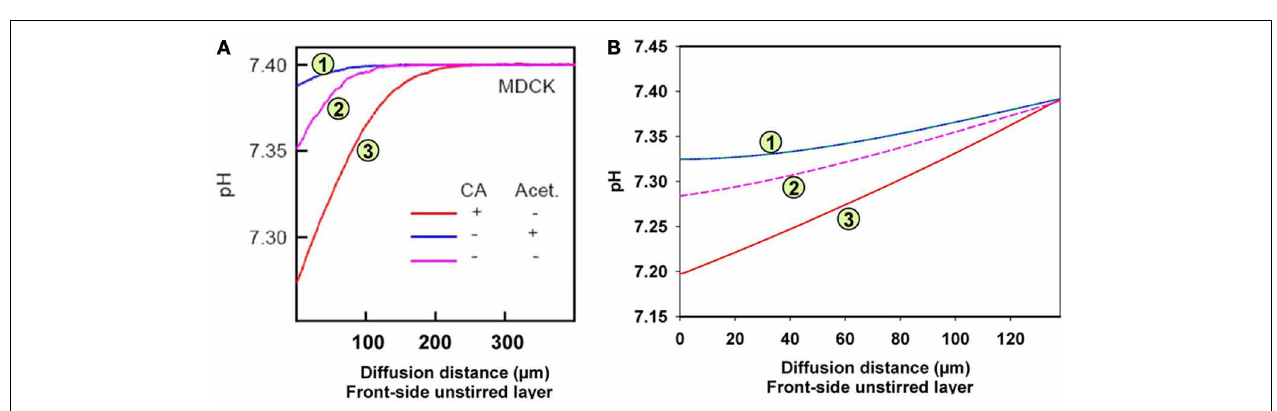
FIGURE 5 | Scheme of the mathematical model used to simulate the CO 2 flux measurements of Zocher et al. (2012). MDCK cell monolayers were exposed to an extracellular solution on the apical (back) side as well as